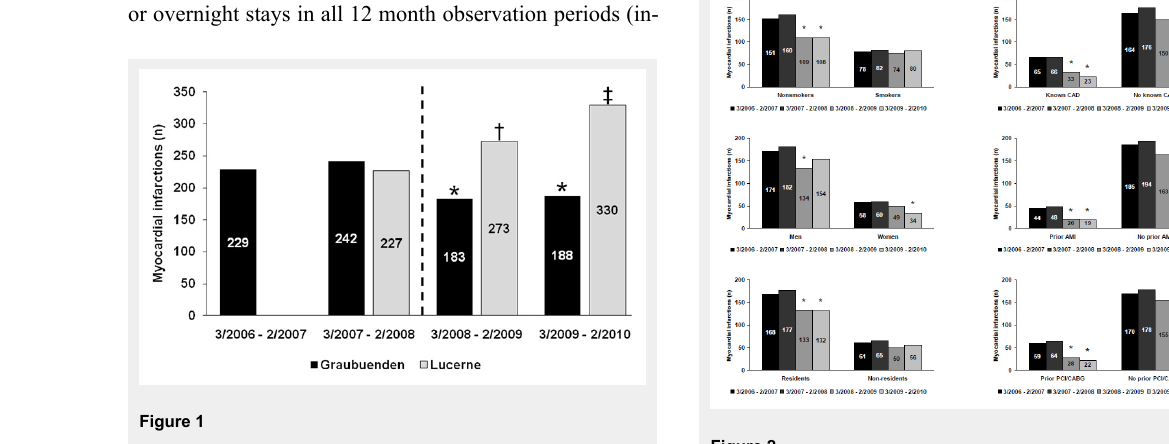
Numbers of myocardial infarctions in various subpopulations in Graubünden in the two 12-month periods before (3/2006 – 2/2007 and 3/2007 – 2/2008) and the two 12-month periods after (3/2008 – 2/2009 and 3/2009 – 2/2010) implementation of a public smoking ban. * P <0.05 vs. each of the two 12-month periods preceding the ban. CAD, coronary artery disease; AMI, acute myocardial infarction; PCI, percutaneous coronary intervention; CABG, coronary artery bypass graft